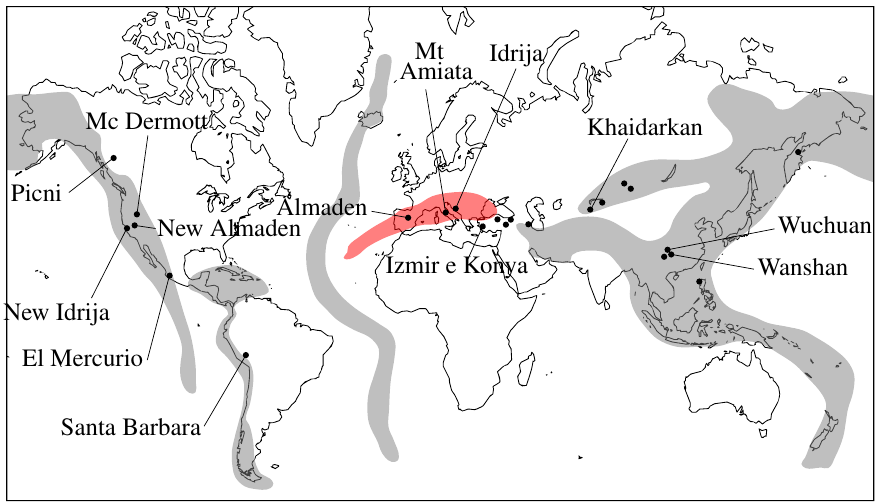
Figure 1. Distribution of mercury (Hg) global belts. The circum-Mediterranean Hg belt (red area) and the most important mining districts for Hg production are reported.